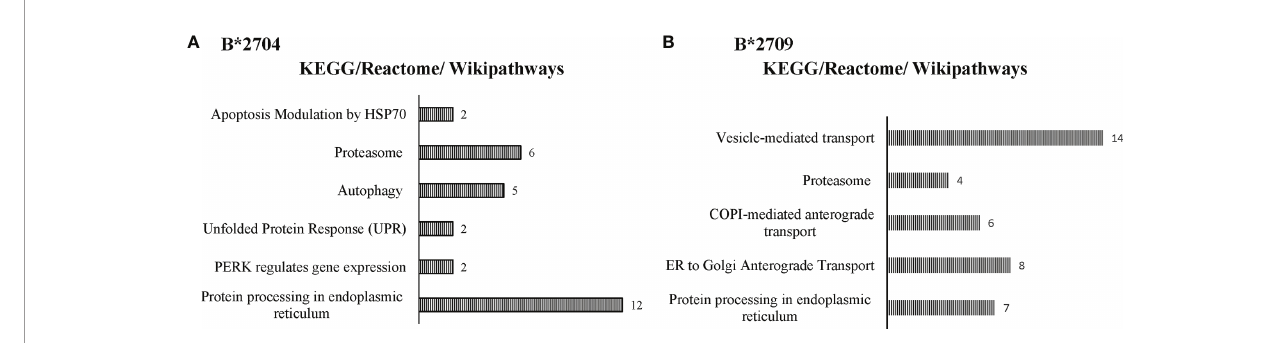
FIGURE 2 | Enriched biological pathways, along with respective protein counts (shown as numbers at the bar-edges) for proteins seen to be differentially upregulated in cells expressing B*2704 (A) and B*2709